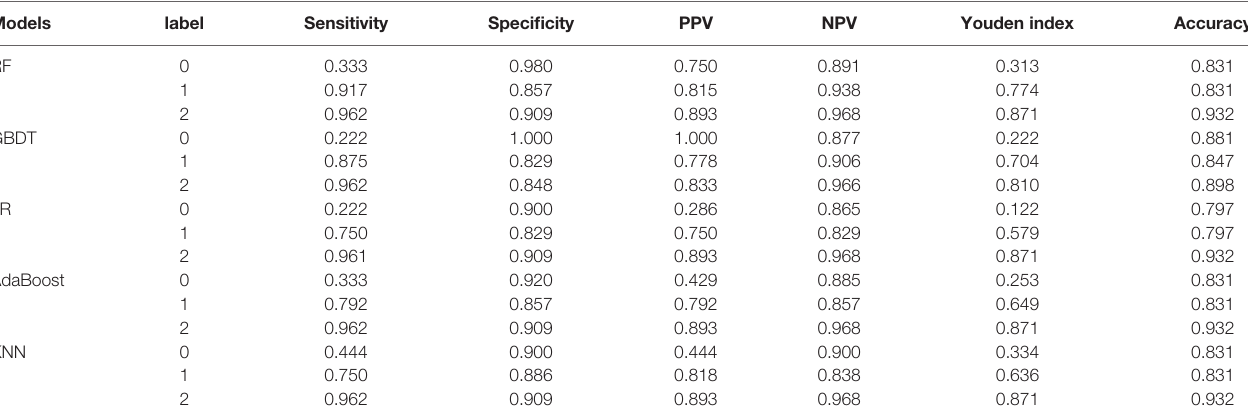
TABLE 2 | Interlabel predictive performance of fi ve ML models. Models